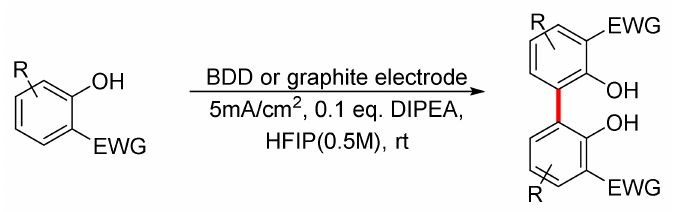
Scheme 7. Optimised conditions for the coupling of electron-poor